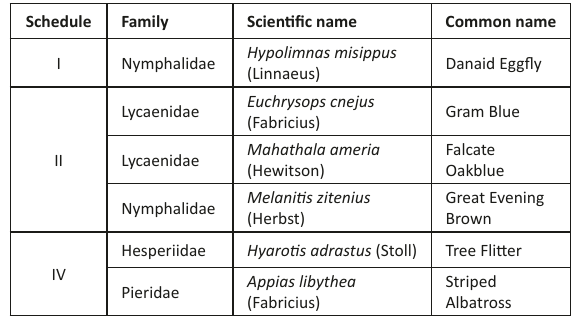
Table: 3. The butterflies of RRS, Chinsurah and adjoining area protected under various schedules of Wildlife (Protection) Act,